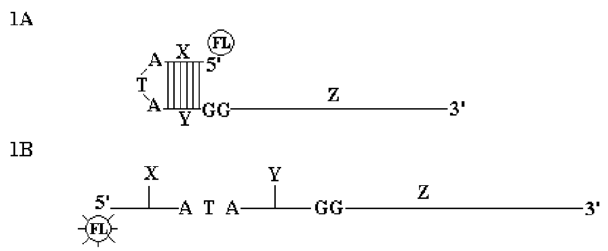
Figure 1. PET-PCR Primer design. The photo-induced electron transfer (PET) primer consists of a quasi-universal tail sequence at 5 9 and sequence specific region at 3 9 . This 5 9 generic tail sequence consists of a 6 base pair stem, 3 nucleotide loop, a single fluorophore attached at 5 9 end and two deoxyguanosine located in the opposite overhang region. The first two dangling end base on the PET primers are deoxyguanosine located at first and second overhang position respectively provided the greatest quenching in the absence of amplification. Circled FL is fluorescence attached to 5 9 . Z is sequence specific primer. X, ATA and Y together form a loop like structure. X and Y are complementary structure. Figure.1B. Fluorescence of PET primer increases during amplification when an extension of the complementary strand takes place. The result of fluorescence increase is due to dequenching effect of deoxyguanosine located in overhang positions and due to the formation of double strand.